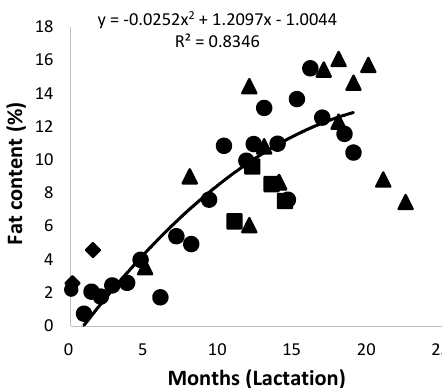
Figure 4. Changes of the total fat content in milk of African elephants during lactation (Shorty ( • ), Bloem ( ♦ ) Mussina ( ■ ), and others ( ▲ )). The trend line of combined data of all elephants was y = − 0.0242x 2 + 1.1098x − 0.0308 and R 2 = 0.6832.